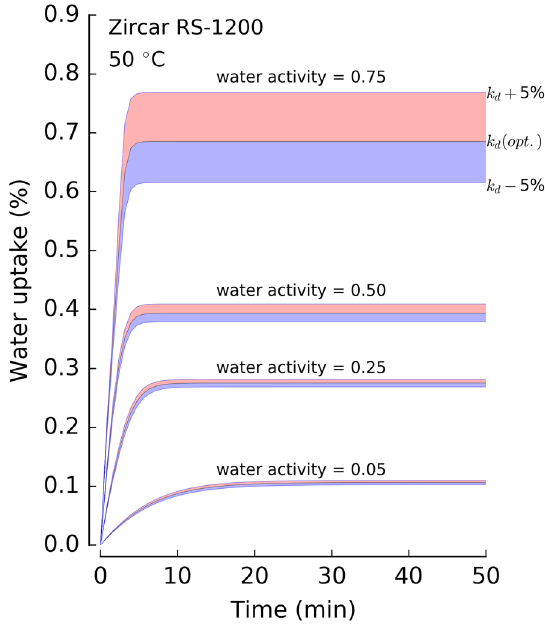
Figure 4. Parameter sensitivity of k d at different water activities in Zircar RS-1200 at 50 °C. Water uptake was computed by simulating our model at different water activities (i.e., stepped watter activity from zero level to 0.05, 0.25, 0.50 and 0.75) by perturbing the Henry’s mode constant k d by 5% while keeping other parameters constant. The middle line in each water activity region corresponds to the uptake computed with SCE optimized k d .